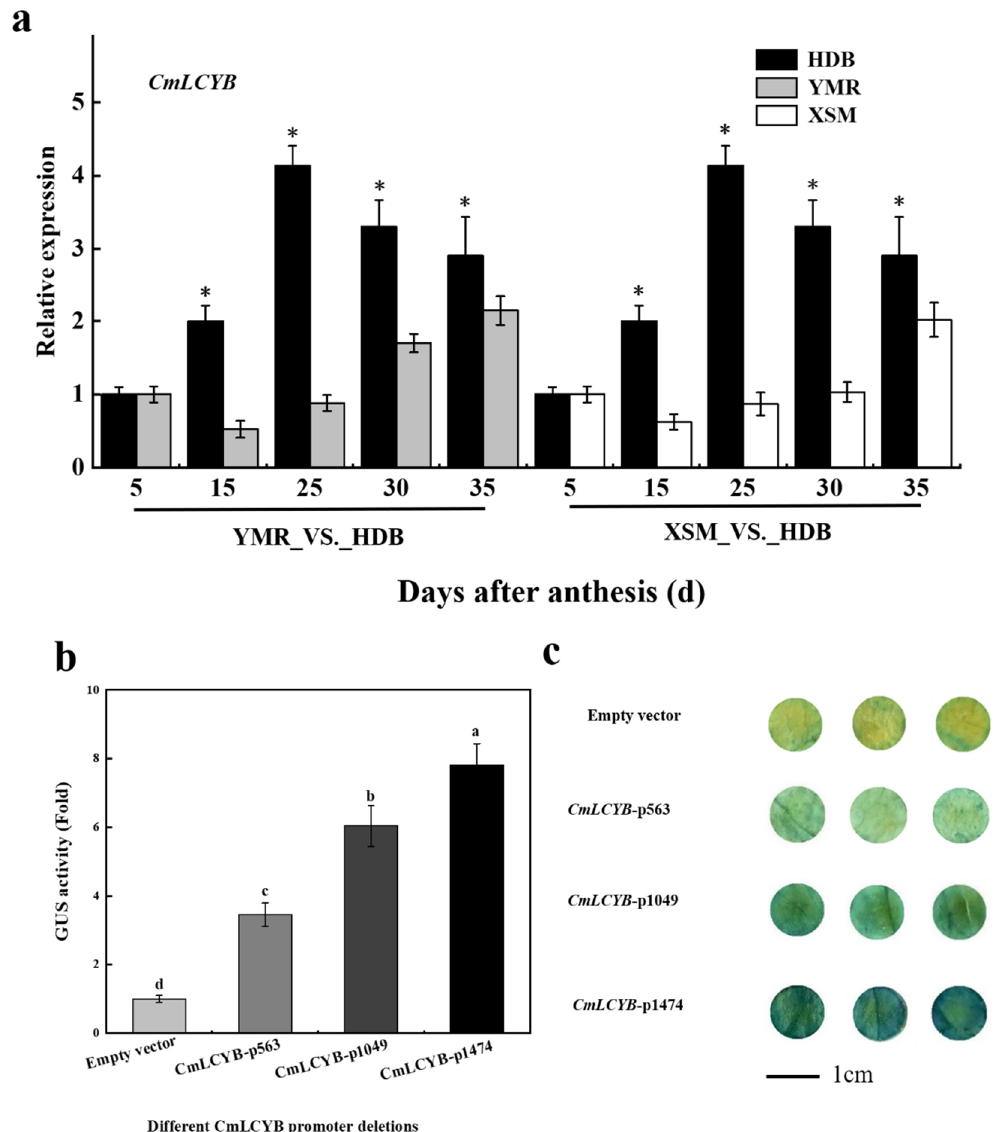
Figure 2. CmLCYB expression profile and its promoter activity. ( a ) The expression of CmLCYB in different flesh-color oriental melons during the different development stages. Values represent the mean ± SE of three replicates. Asterisks indicate significant differences determined by the independent sample t -test (* p < 0.05). ( b ) GUS activity of different promoter fragments. Values represent the mean ± SE of three replicates. Different letters represent a statistically significant difference at the different days after anthesis (* p < 0.05). ( c ) GUS histochemical staining of different promoter fragments.